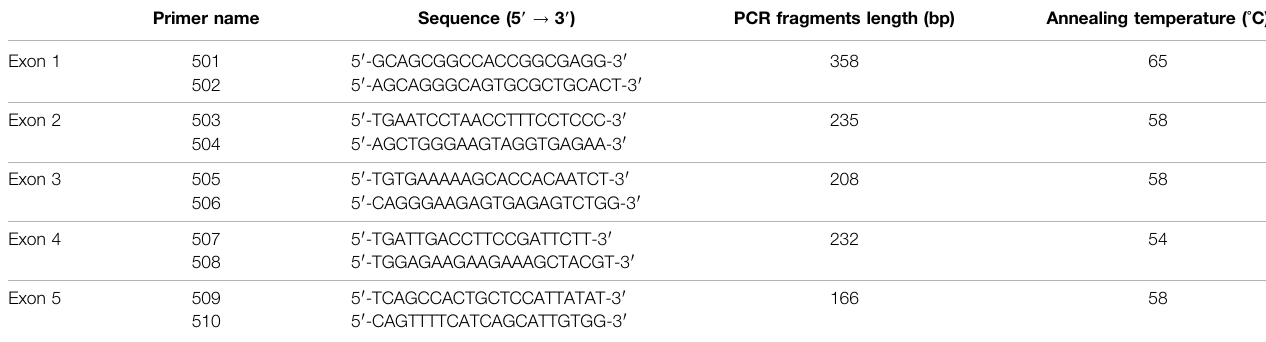
TABLE 1 | Oligonucleotides used for ampli fi cation of each exon of the SRD5A2